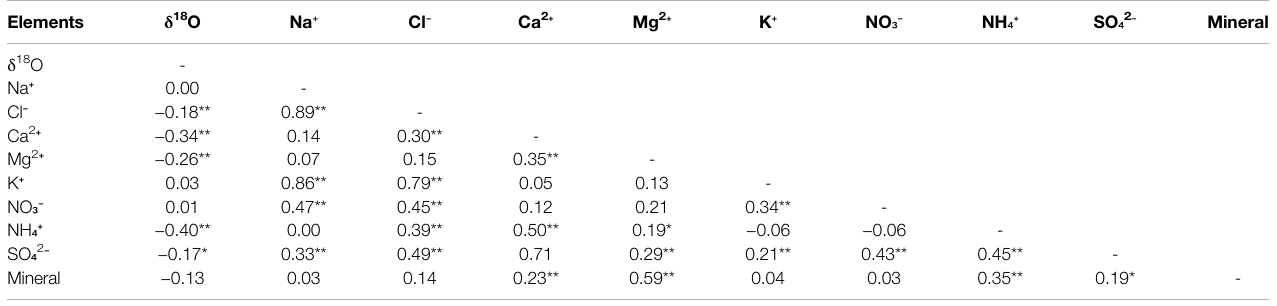
TABLE 2 | Correlation coef fi cients between stable isotope, major ions and mineral dust in the ice core collected from the ablation area (Core A). Elements